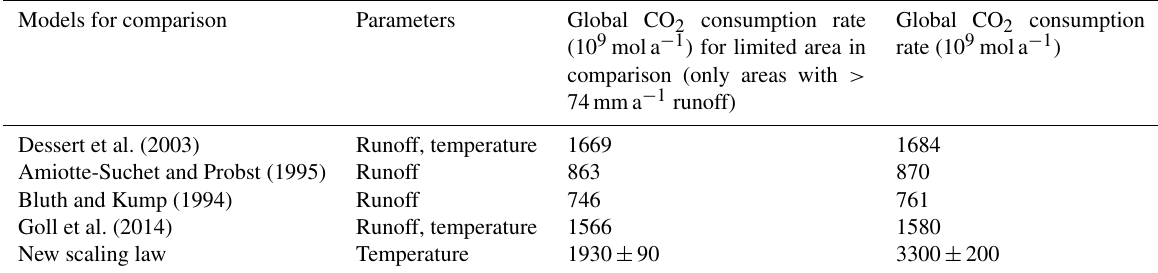
Table 1. Summary of global basalt CO 2 consumption rates for different models and the new parameterization. For simplicity, it was assumed that alkalinity fluxes equal CO 2 consumption. The percentiles of the values of the global calculation by the new scaling law (Monte Carlo method) can be found in the Supplement. The standard deviation is given below as described in the